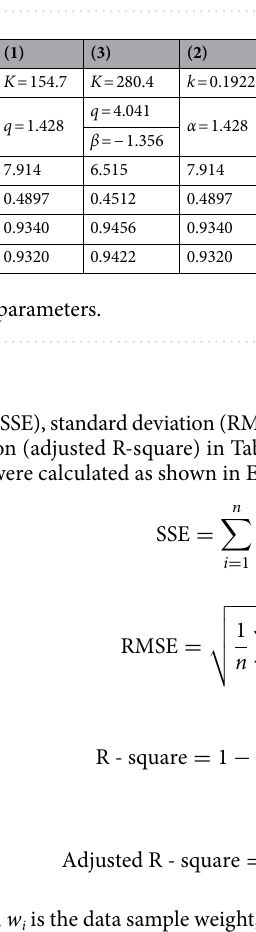
Figure 4. Fitting curve of site test: ( a ) Base formula fitting. ( b ) Improved formula fitting.